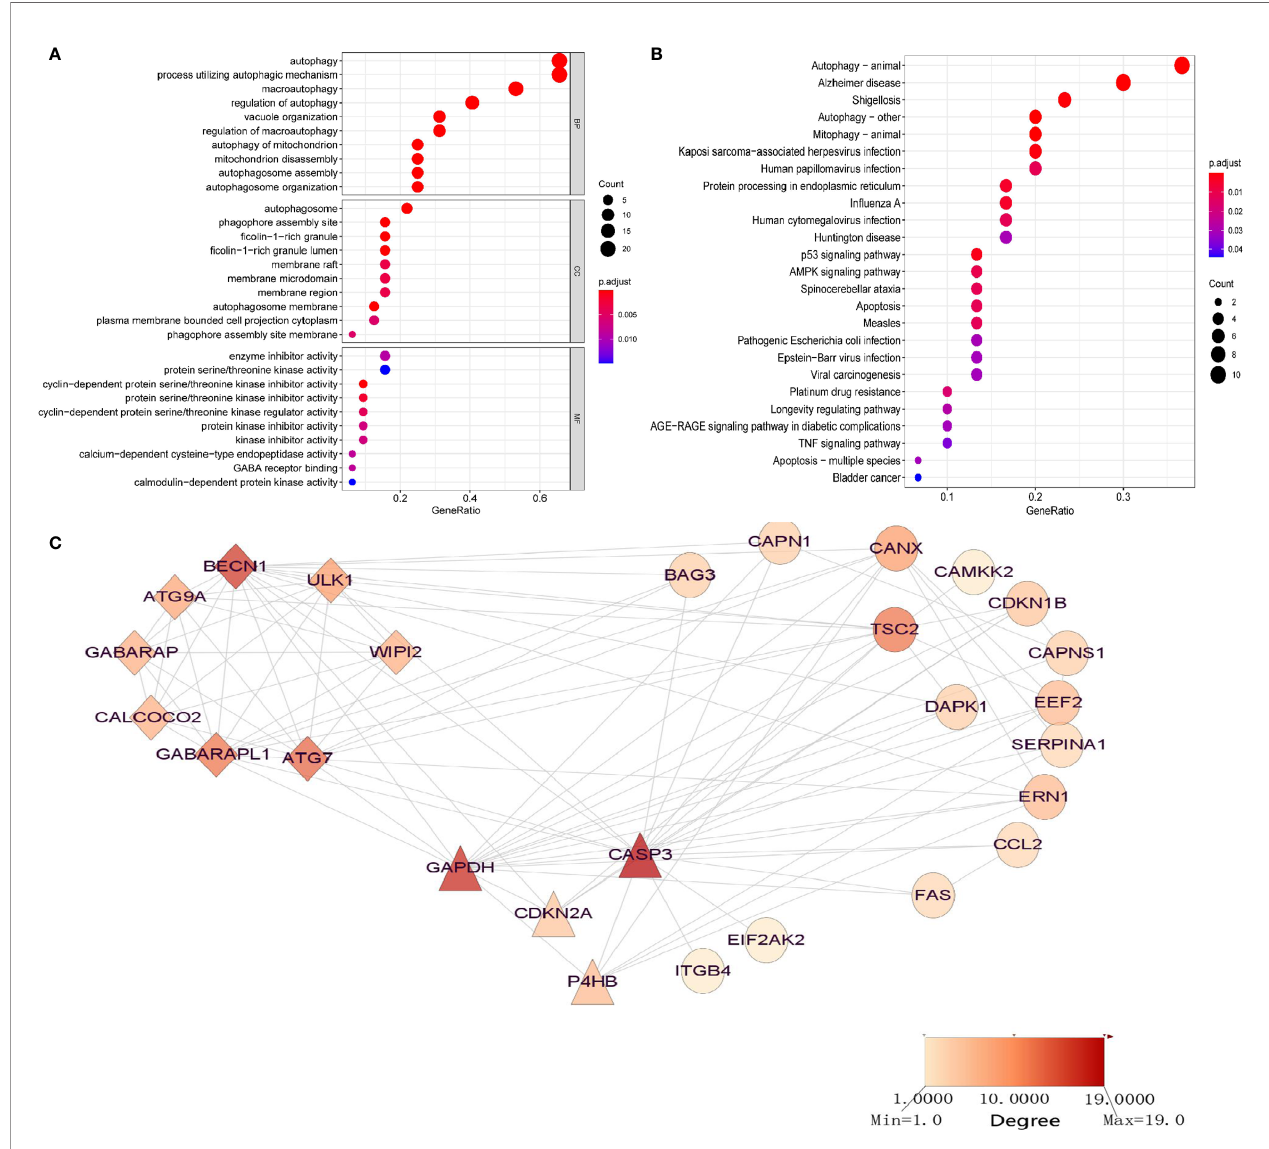
FIGURE 1 | Signi fi cantly enriched GO terms and KEGG pathways of OS-related autophagy-related genes (ARGs) (adjusted P < 0.05). (A) Signi fi cantly enriched GO terms of OS-related ARGs. (B) Signi fi cantly enriched pathways of OS-related ARGs. (C) Two modules (CASP3 and BECN1 modules) identi fi ed through protein – protein interaction network analysis of OS-related ARGs. The color of the node in each module re fl ects its degree